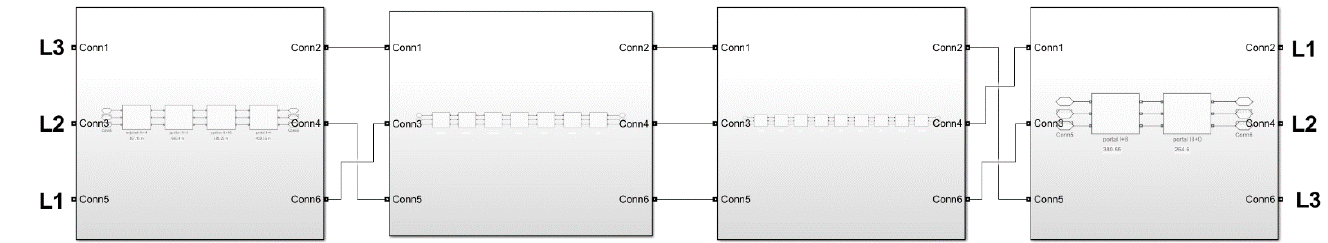
Figure 7. Complete MATLAB Simulink model of the investigated overhead 400 kV power line. The crossed connectors between blocks are symbolizing the phase transposition.